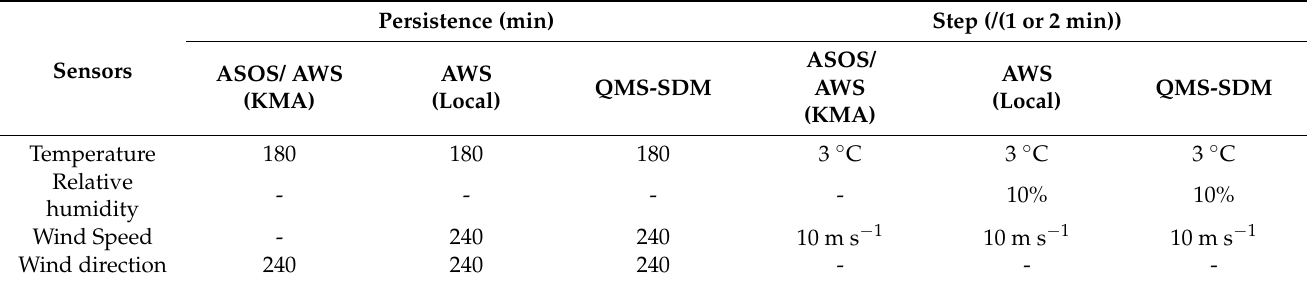
Table 5. Threshold values for persistence and step checks applied to the ASOS/AWS operated by KMA, AWS operated by the local government, and QMS-SDM in